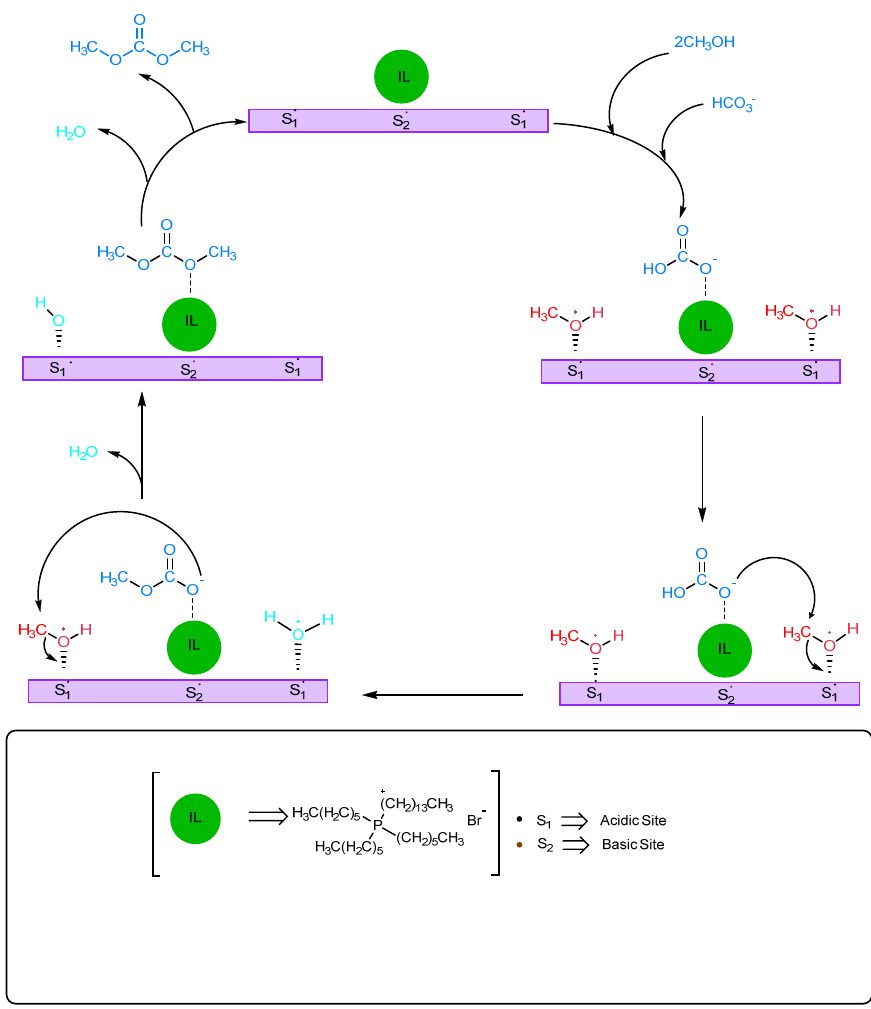
Figure 3. Reaction mechanism for the conversion of CO 2 and methanol to DMC proposed by Kabra et al. [28]. (Reprinted with permission from Ref. [28], 2016, Elsevier). To study the effect of acidity and basicity of the transition metal oxide-based catalysts, Lee et al. [47] prepared various MO/Ce 0.6 Zr 0.4 O 2 catalysts, where MO = Ga 2 O 3 , Ni 2 O 3 , La 2 O 3 , Fe 2 O 3 , Co 3 O 4 , Y 2 O 3 , and Al 2 O 3 . The catalyst activity was investigated for the direct DMC synthesis from methanol and CO 2 . NH 3 -TPD and CO 2 -TPD were carried out for determining the acidity and basicity of MO/Ce 0.6 Zr 0.4 O 2 catalysts. The acidity of the catalysts Ce 0.6 Zr 0.4 O 2 , Ga 2 O 3 /Ce 0.6 Zr 0.4 O 2 , La 2 O 3 /Ce 0.6 Zr 0.4 O 2 , Ni 2 O 3 /Ce 0.6 Zr 0.4 O 2 , Fe 2 O 3 /Ce 0.6 Zr 0.4 O 2 ,